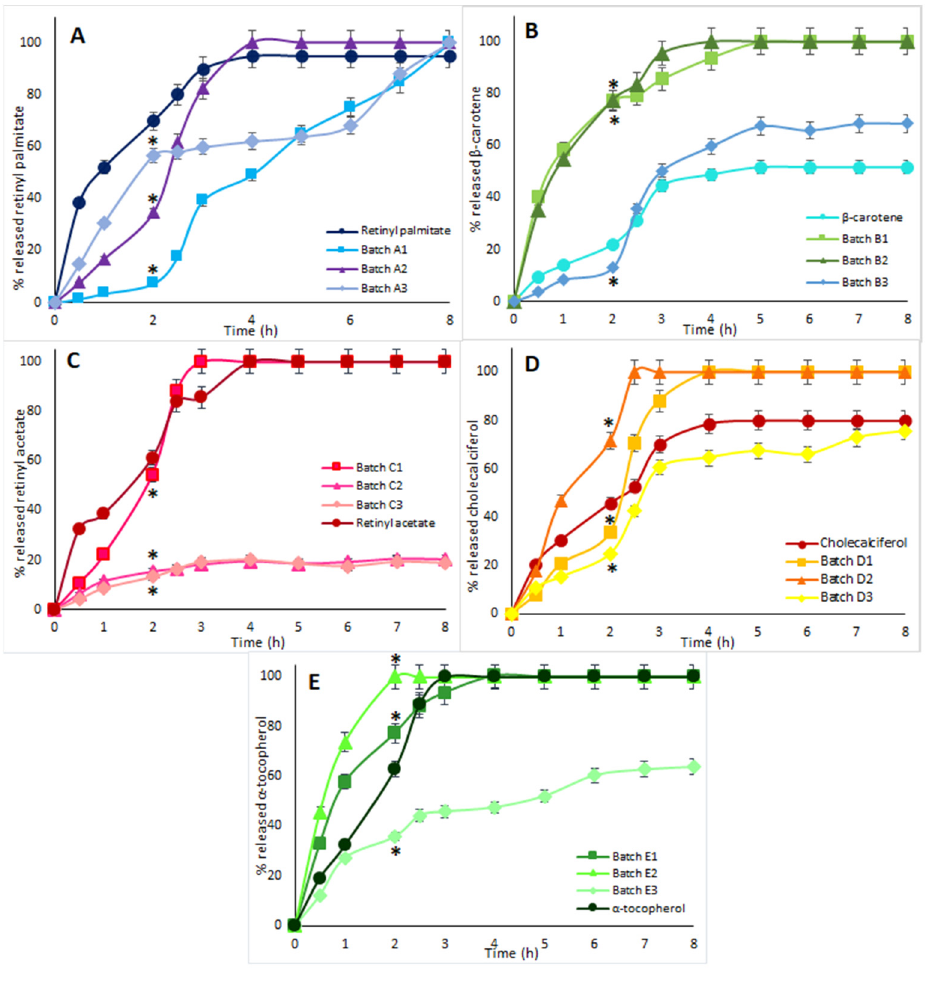
Figure 5. Graphs of the percentage of vitamin released as a function of time: ( A ) retinyl palmitate, batches A1, A2, A3 and pure retinyl palmitate; ( B ) β -carotene, batches B1, B2, B3 and pure β -carotene; ( C ) retinyl acetate, batches C1, C2, C3 and pure retinyl acetate; ( D ) cholecalciferol, batches D1, D2, D3 and pure cholecalciferol; ( E ) α -tocopherol, batches E1, E2, E3 and pure α -tocopherol (mean ± SD, n = 3). p < 0.05 ( * ) for all tested batches versus pure vitamins after 2 h.